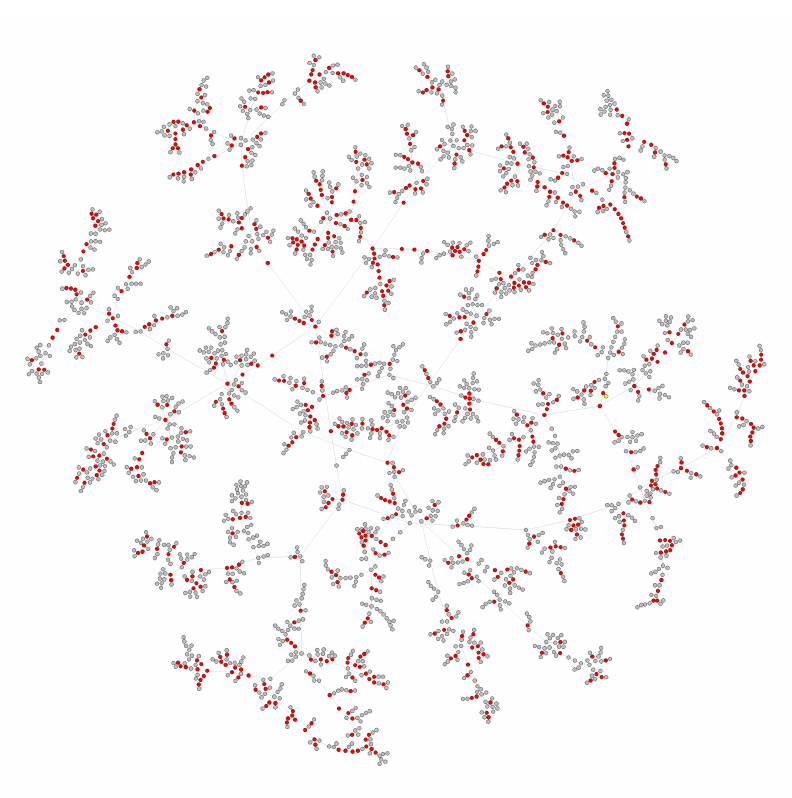
Figure A3. The inferred Alberta transmission